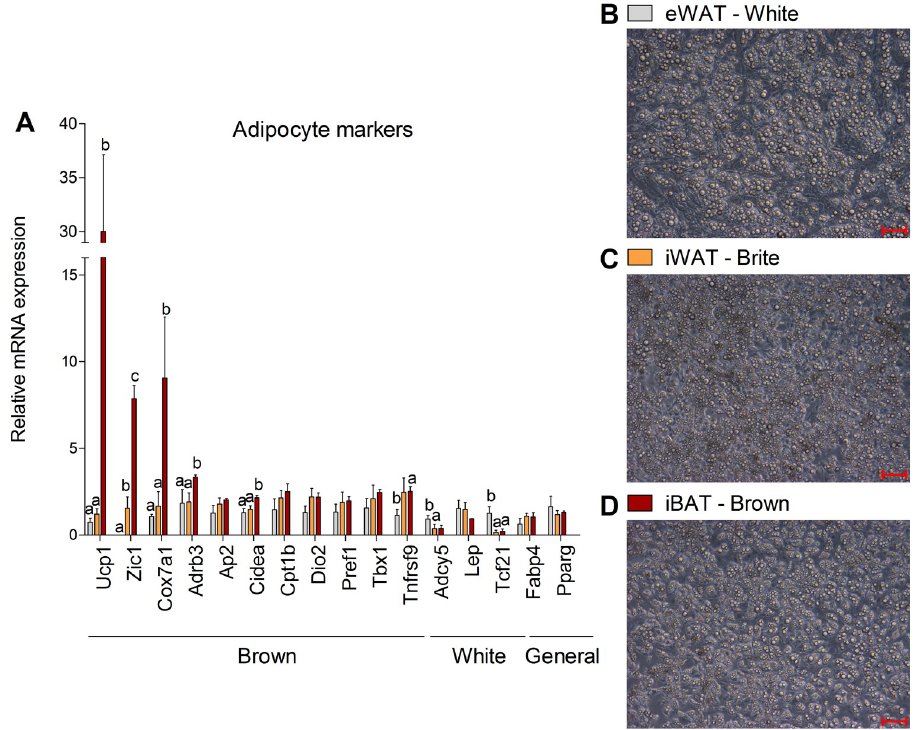
Fig 1. Characterization of eWAT, iWAT, and BAT derived adipocytes. (A) Expression profile of genes that have been linked previously to white or brown adipocytes, WAT or BAT, or AT browning. Shown are means ± SD of 3 mice; annotation of “a, b” indicates that group "a" is statistically different from "b"; annotation of “a, b, c” indicates that all 3 groups are significantly different from each other; significant difference was tested using a one-way ANOVA (Post Hoc: Tukey Test; p < 0.05). (B–D) Representative images show eWAT, iWAT, and BAT derived adipocytes; the “bright dots” are lipid droplets; images are scaled equally; the red line equals 100 μ m. The underlying data of (A) can be found in S1 Data. BAT, brown adipose tissue; iBAT, intrascapular brown adipose tissue; eWAT, epididymal white adipose tissue; iWAT, inguinal white adipose tissue; WAT, white adipose